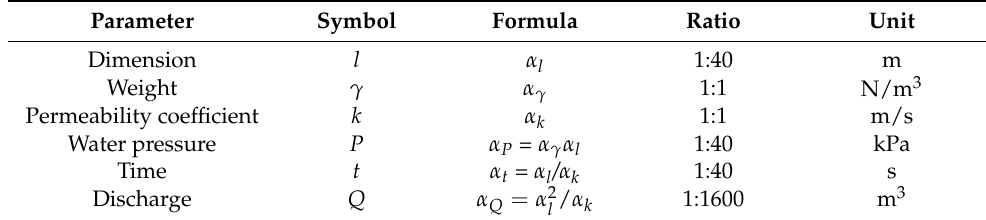
Table 1. The similarity ratios of the materials.